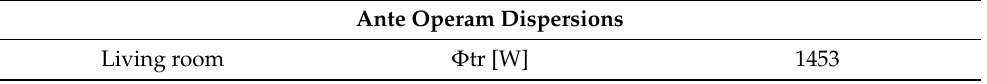
Table 4. Living room: simulated dispersions; ante operam monitoring period; climatic zone C.